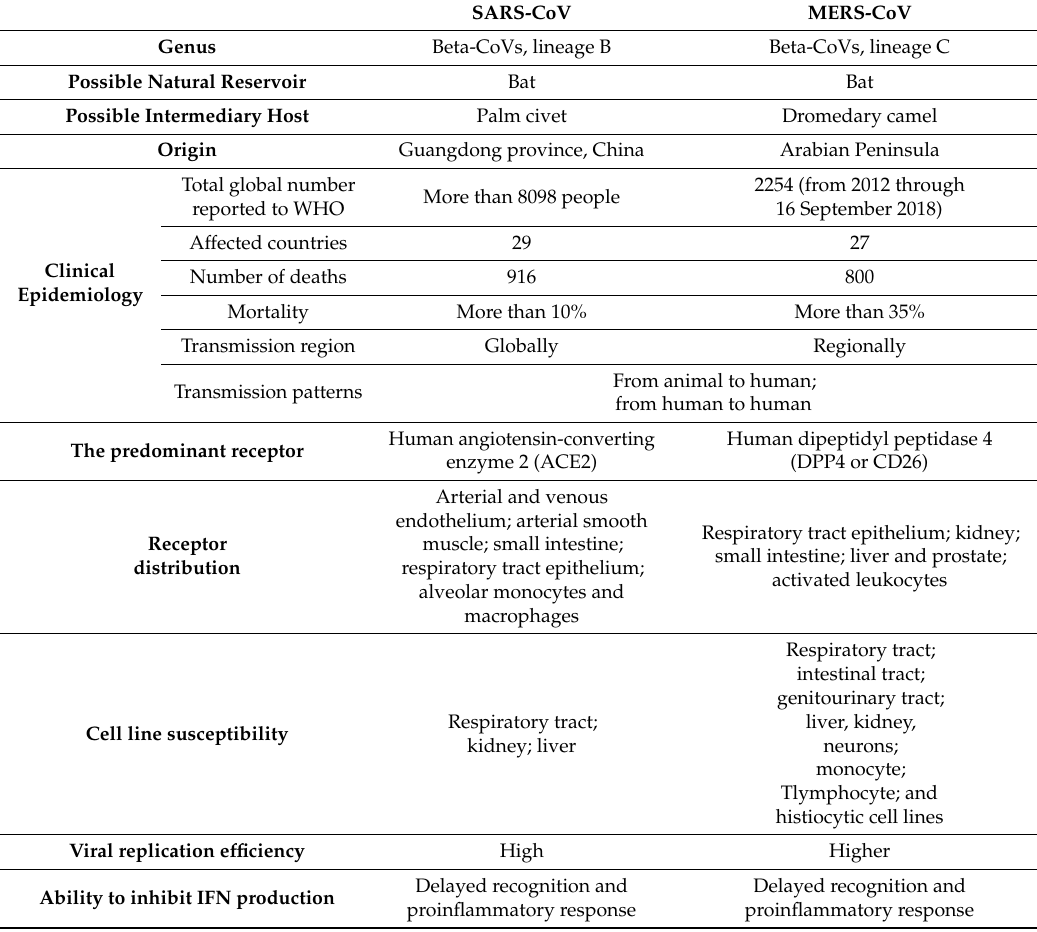
Table 1. Epidemiology and biological characteristics of the severe acute respiratory syndrome coronavirus (SARS-CoV) and the Middle East respiratory syndrome coronavirus